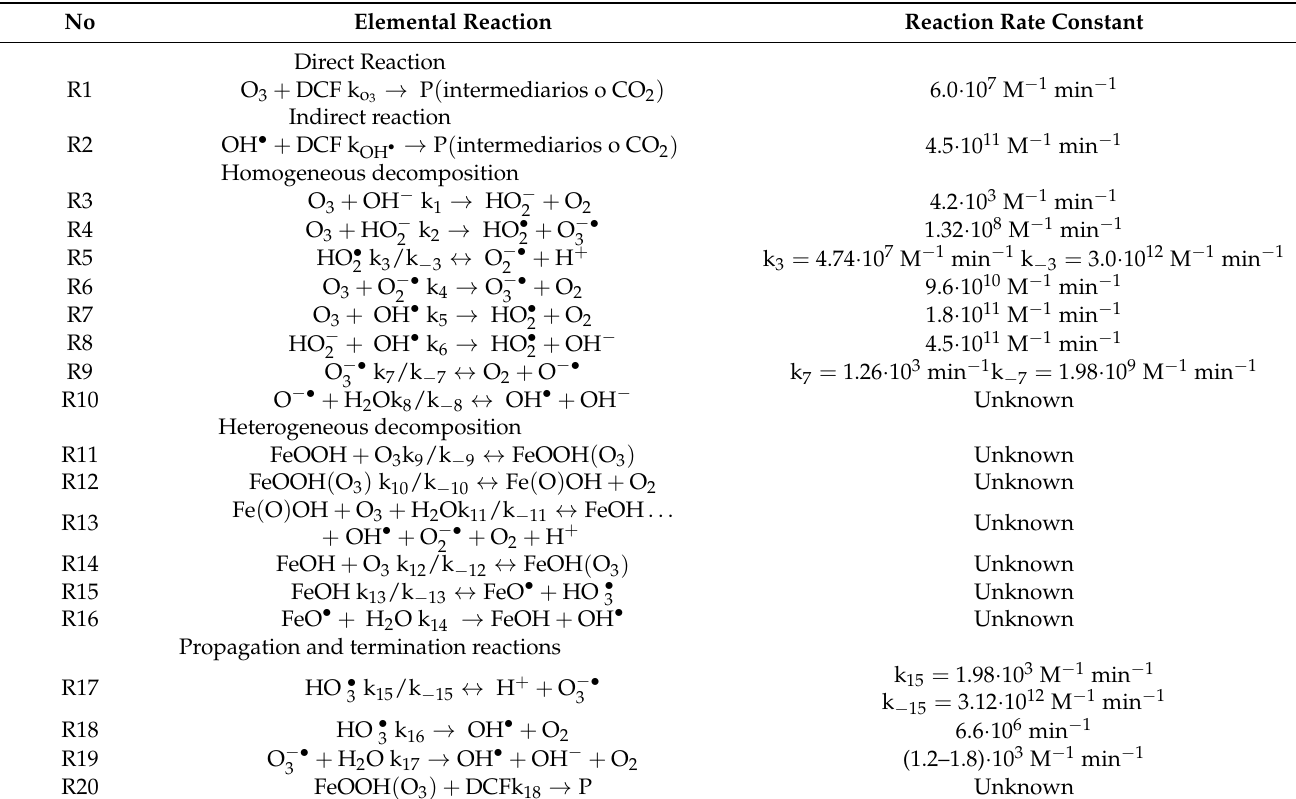
Table 2. Heterogeneous catalytic elementary reactions in ozonation with Goethite